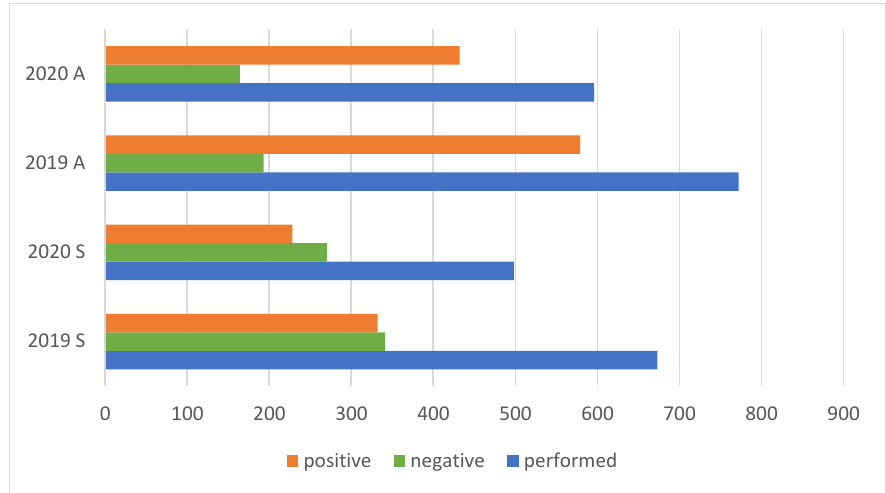
Figure 3. U rine cultures. Figure 3. Urine